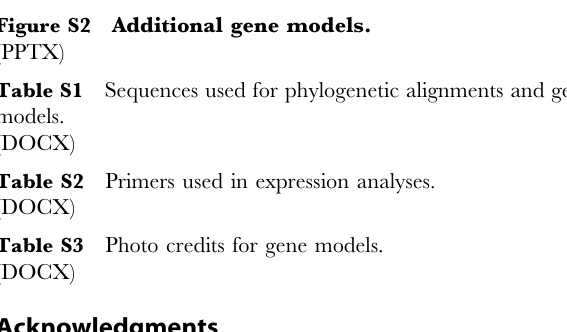
Table S1 Sequences used for phylogenetic alignments and gene models. Table S2 Primers used in expression analyses. Table S3 Photo credits for gene